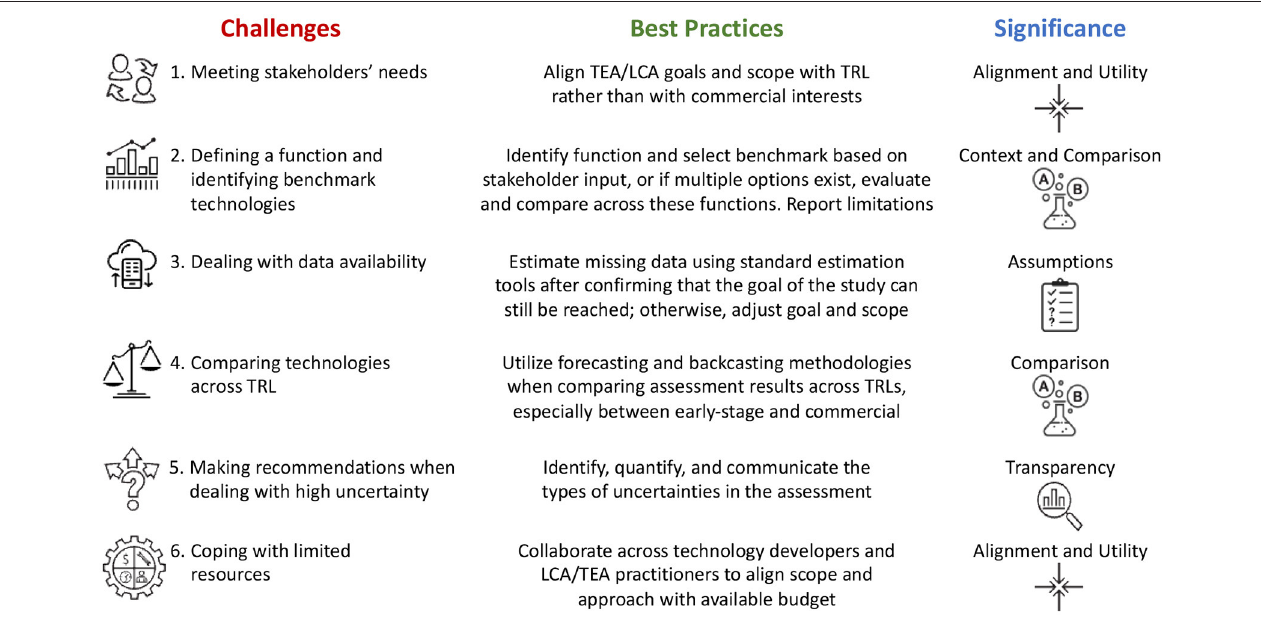
FIGURE 3 | Summary of the identified challenges, corresponding best practices, and significance in LCA and TEA practice for assessment of early-stage